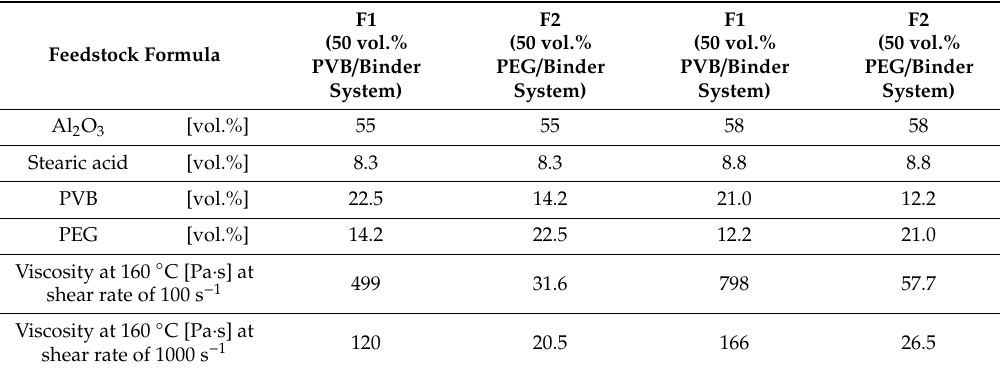
Table 2. Viscosity at 160 ◦ C (operating temperature) of alumina feedstocks with 55 or 58 vol.% powder loading based on binder systems containing 50 vol.% of the backbone polymer PVB (F1) or 50 vol.% of the lower molecular binder component PEG 4000